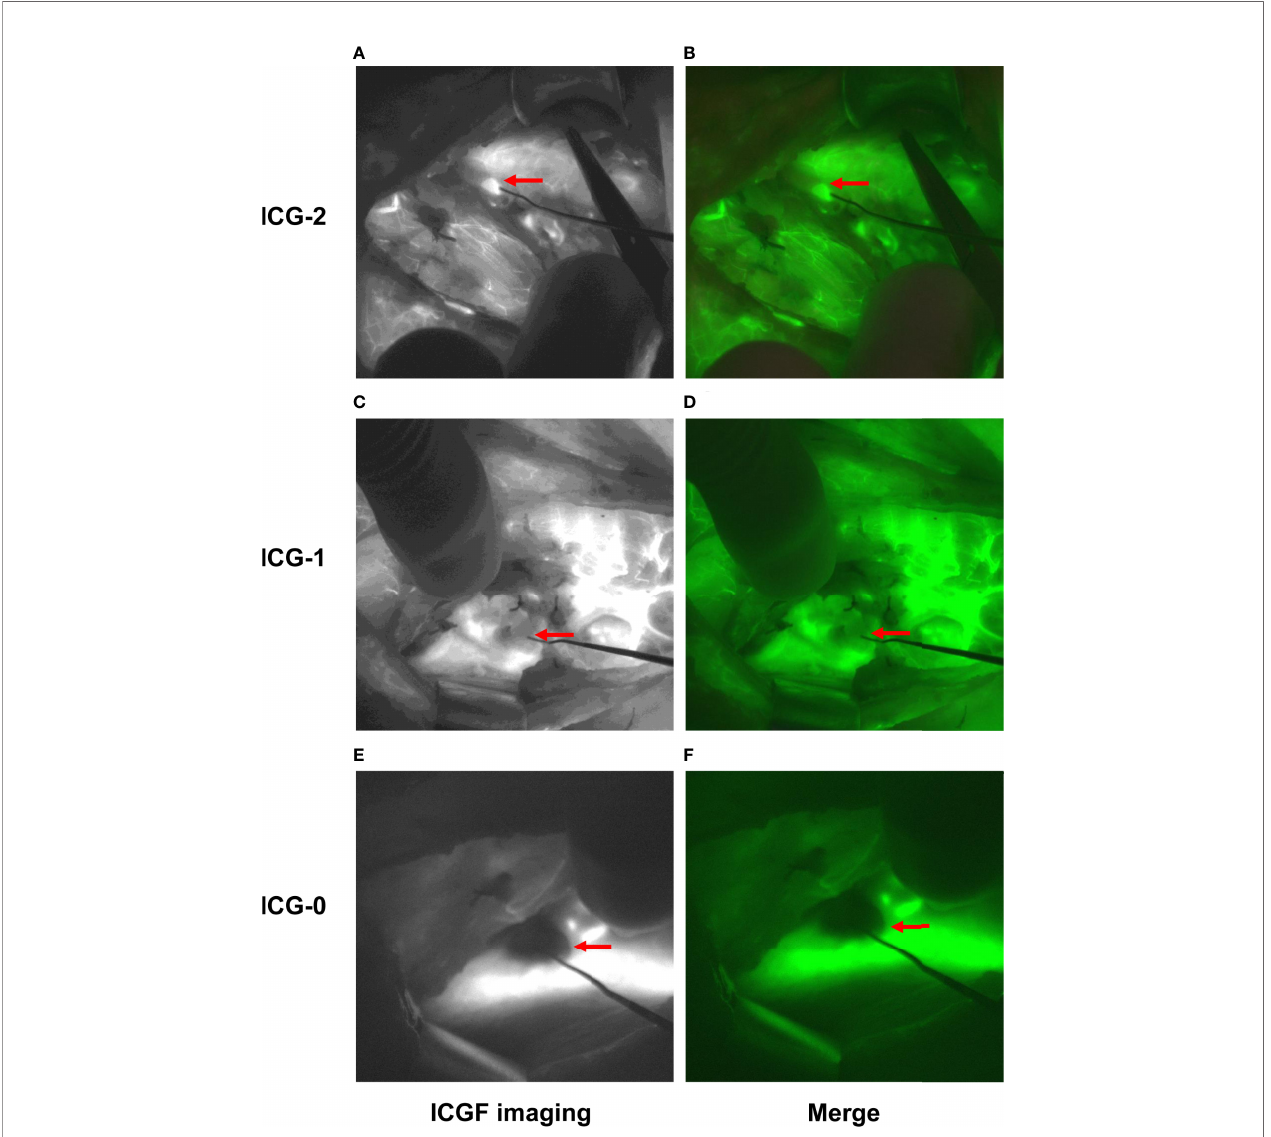
FIGURE 3 | Typical images of PGs assessed by ICGF. Fluorescence images were obtained 30 seconds after intravenous injection of ICG. Images (A, B) show the PG with an ICG score of 2. Images (C, D) show the PG with an ICG score of 1. Images (E, F) show the PG with an ICG score of